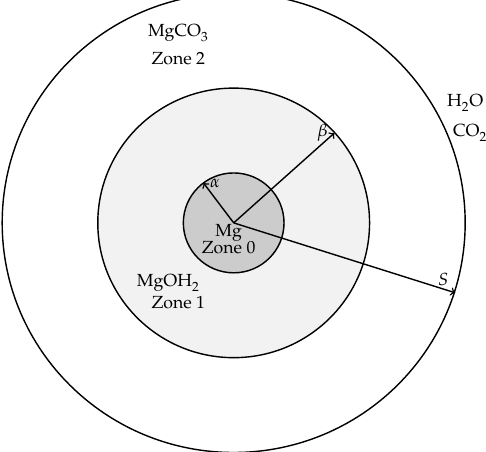
Figure 1. A physiochemical schematic of the magnesium corrosion system used in the model for cylindrical and spherical geometries. The pure magnesium or magnesium alloy exists in the core (Zone 0, 0 ≤ r < α ( t ) ), the magnesium hydroxide forms a middle layer (Zone 1, α ( t ) < r < β ( t ) ) and the outer layer consists of magnesium carbonate (Zone 2, β ( t ) < r < S ( t )